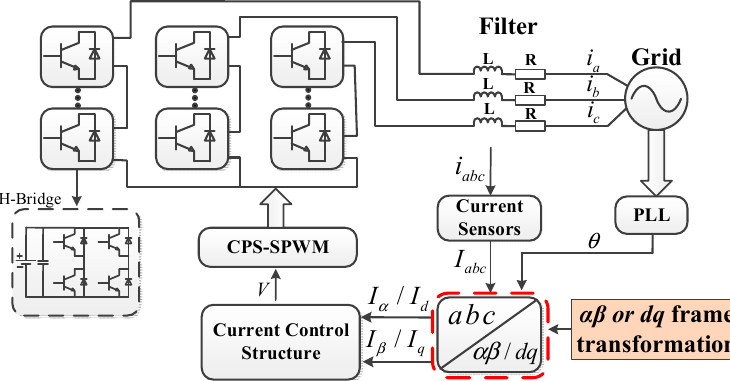
Figure 1. Block diagram of cascaded H-bridge grid-connected inverter.